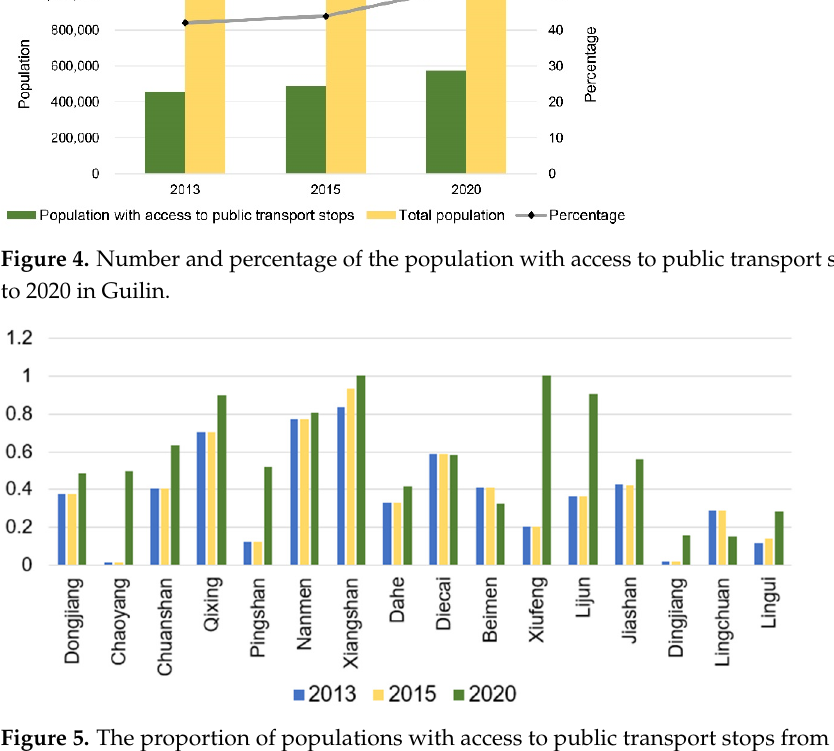
Figure 5. The proportion of populations with access to public transport stops from 2013 to 2020 in the townships of Guilin.